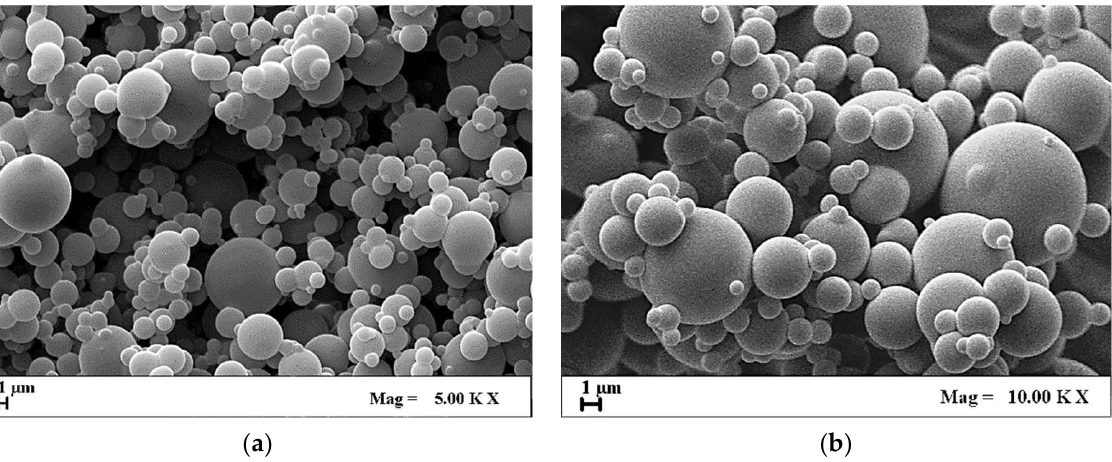
Figure 7. FESEM images of coprecipitated PVP/TOC particles at a 5/1 ( a ) and 3/1 ( b ) ratio, at 90 bar and 313 K.